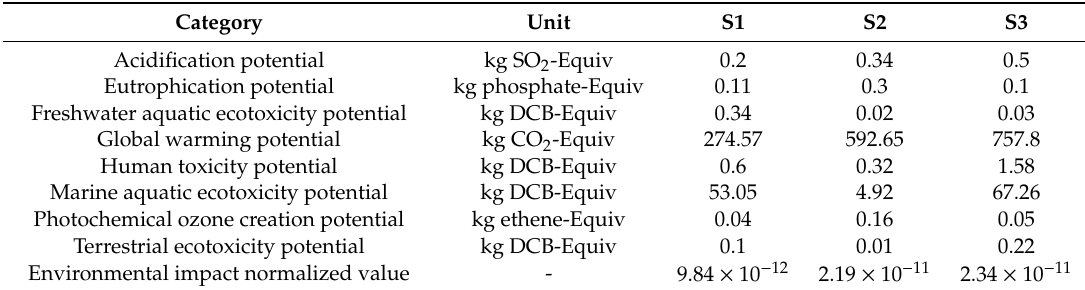
Table 2. Environmental impact of di ff erent methods of treating restaurant food waste. Equiv—